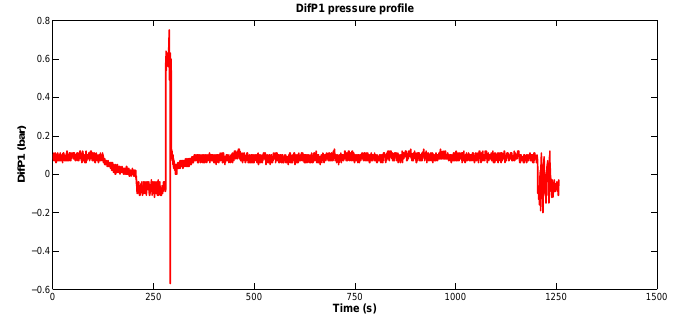
Figure 10. DifP1 pressure profile. Source: By authors.